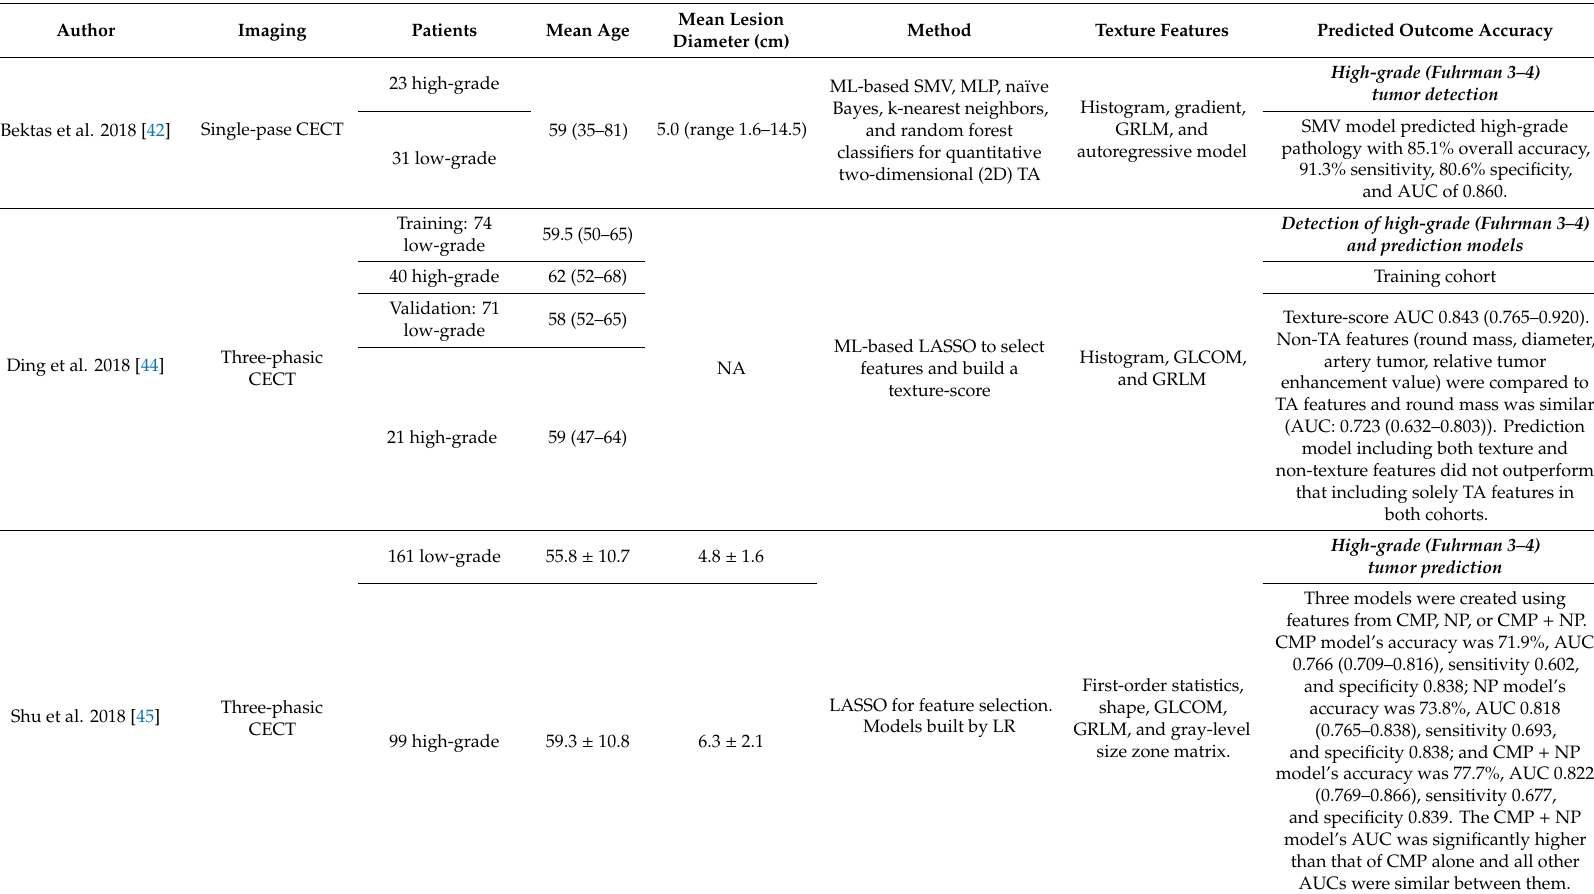
Table 2. Summary of studies applying radiomics to predict nuclear grade in